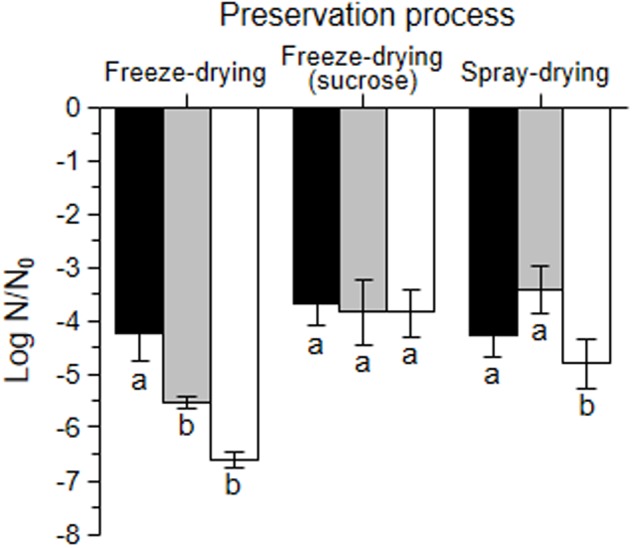
Log N/N0 of L. plantarum CIDCA 83114 grown in whole okara (black bars), defatted okara (gray bars) and in MRS (white bars) after freeze-drying (left group of bars), freeze-drying with sucrose (middle group of bars) and spray-draying (right group of bars). N0 corresponds to viable plate counts of fresh cultures in the stationary phase before each treatment, and was 13.60 ± 0.30 log CFU/mL for whole okara, 13.35 ± 0.53 log CFU/mL for defatted okara, and 13.68 ± 0.42 log CFU/mL for MRS. N corresponds to viable plate counts immediately after each treatment (log CFU/mL). Different letters (a, b) denote statistically significant differences (p < 0.05).